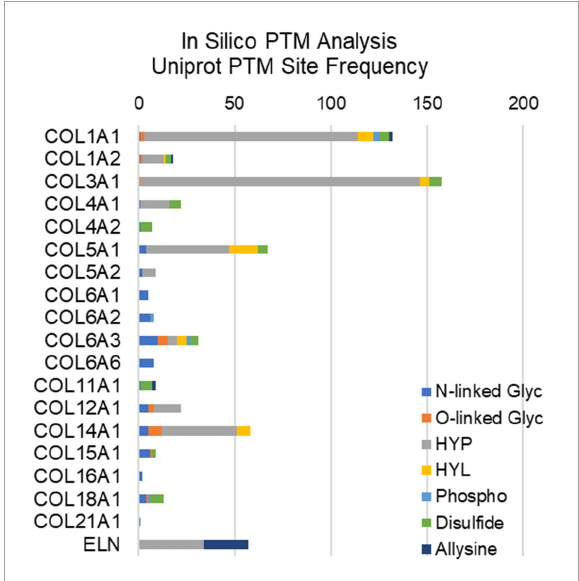
FIGURE2 In silico post-translational modification (PTM) site frequency analysis of valvular structural proteins (collagens and elastin); uniport reporting. Glyc, glycosylation; HYP, hydroxyproline; HYL, hydroxylysine; Phospho,